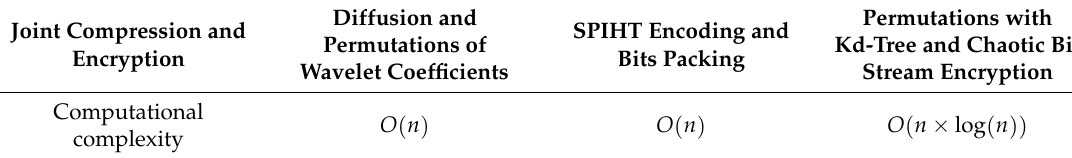
Table 10. Computational complexity.